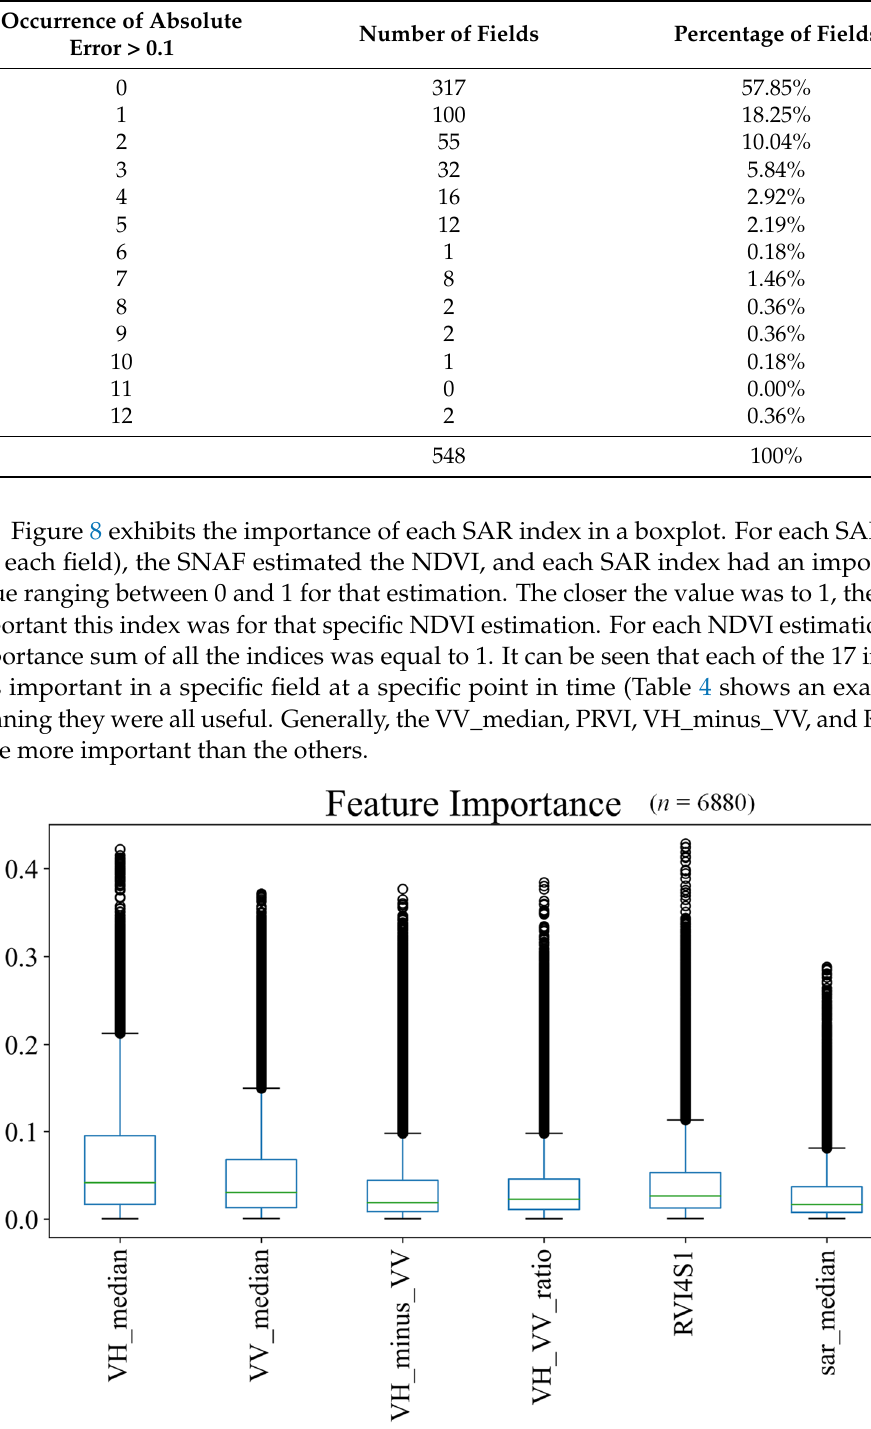
Figure 8. Feature importance of all indices used in the SNAF method. The closer the importance is to 1, the more important that index was for a specific field for a specific point of time. Note that each index was important at some point in time.